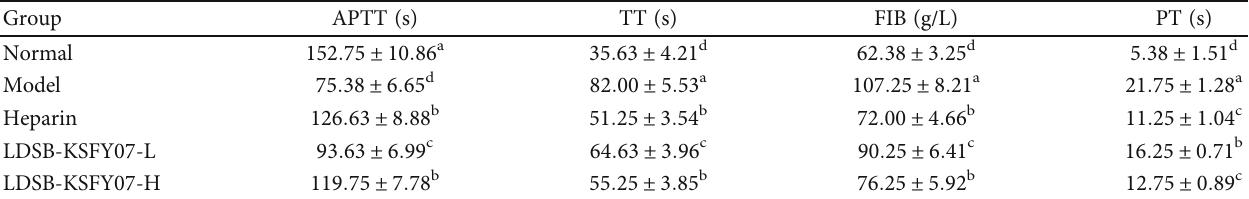
The results have been expressed as mean ± deviation . a – d Mean values with di ff erent letters in the di ff erent column are signi fi cantly di ff erent ( P < 0 : 05 ) according to Duncan ’ s multiple range